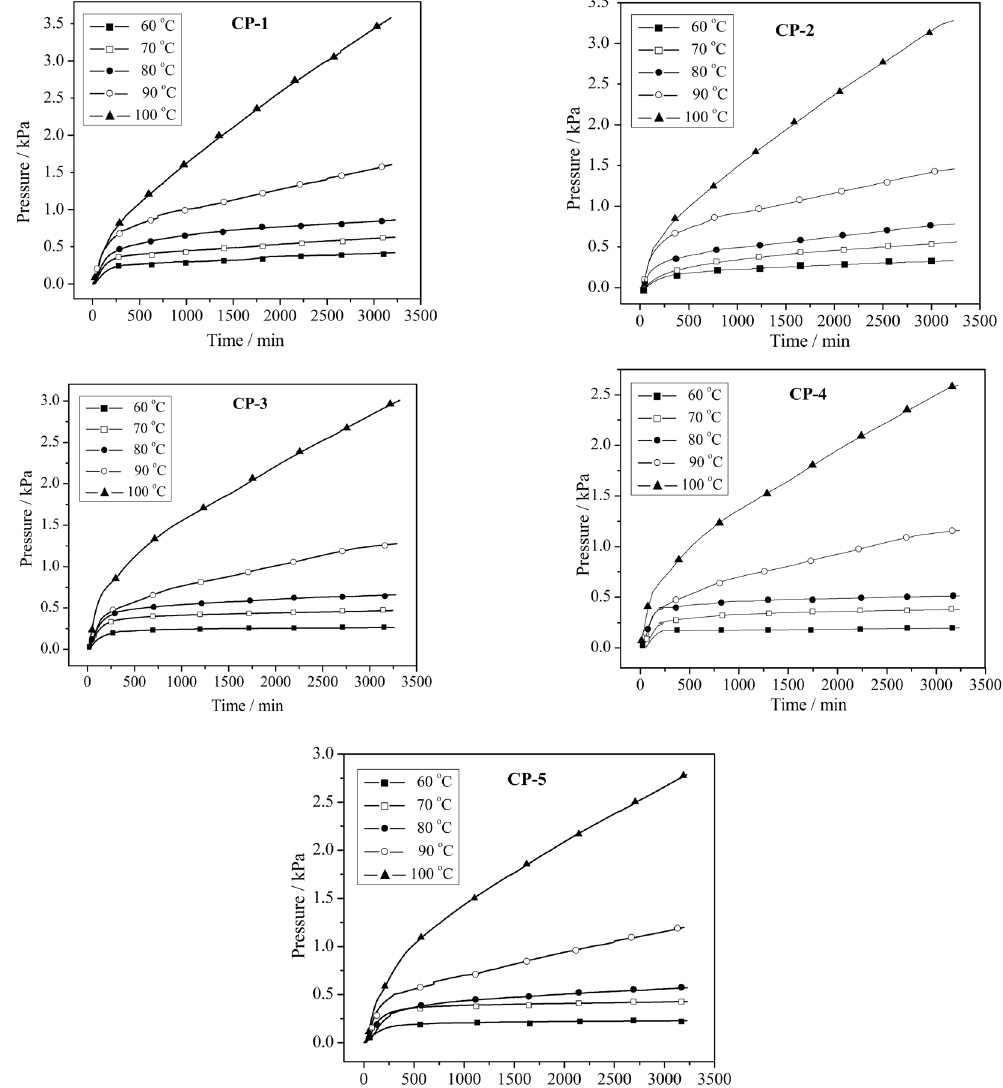
Figure 1. DPTA curves of the composite modified double-base